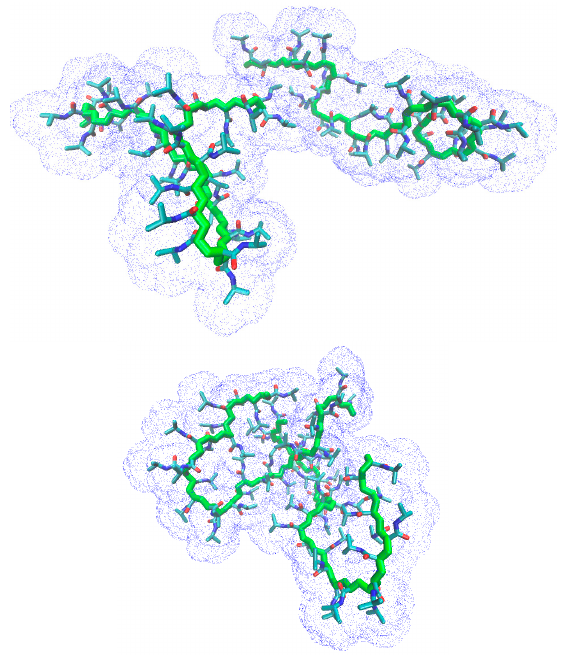
Figure 6. Snapshot at 202 ns of the trajectory of the atactic ( top ) and isotactic-rich ( bottom ) PNIPAM ensemble at 283 K. Water and hydrogen atoms are omitted. The blue dots display the solvent accessible surface.